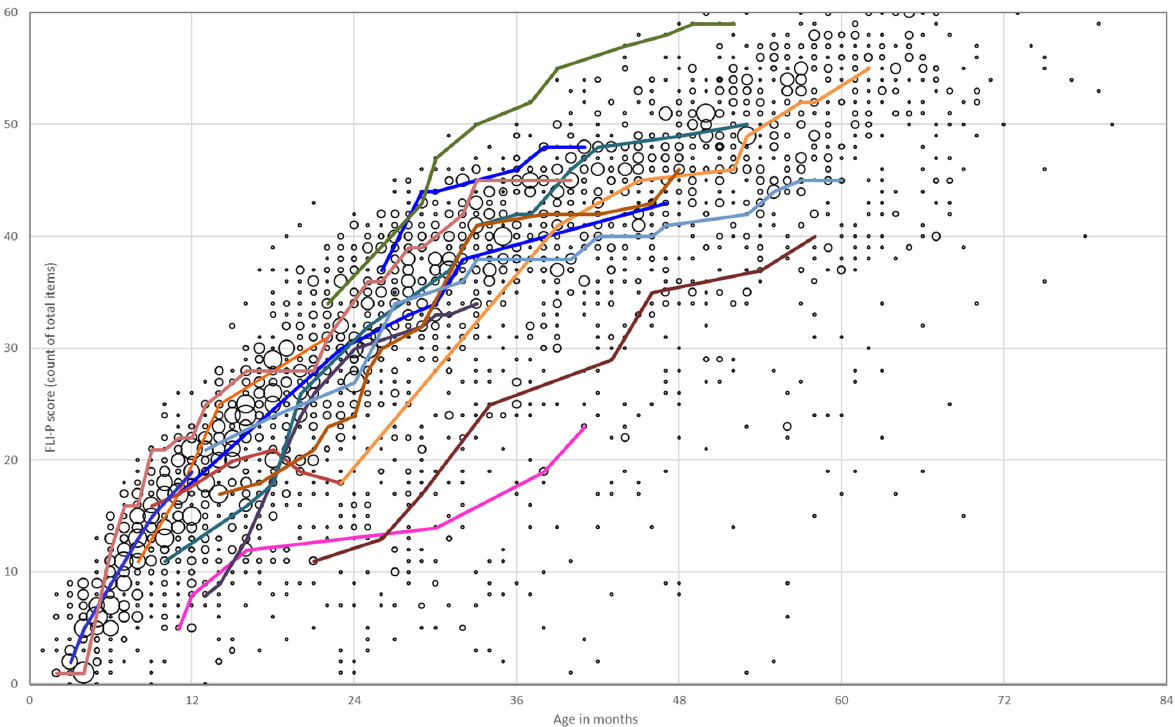
Figure 4. Individual trajectories of FLI-P scores for children with cochlear implants, bilateral severe, severe–profound, and profound hearing loss and a diagnosed additional disability. Each of the colored lines represents an individual child’s trajectory to highlight progress and different listening development trajectories.